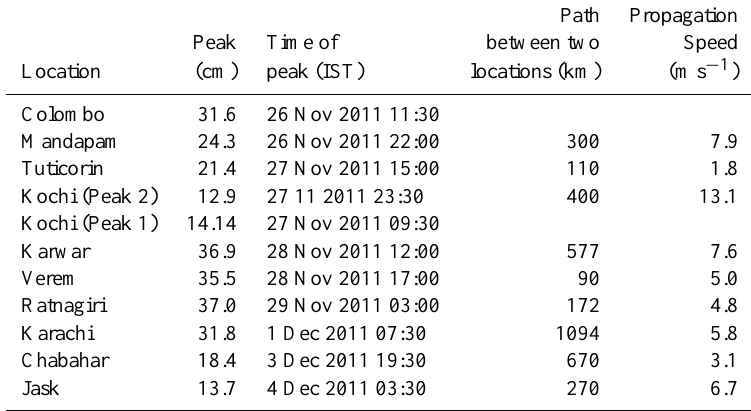
Table 7. Surge propagation parameters during E1 along the west coast of Indian continent. Path Propagation Peak Time of between two Speed Location (cm) peak (IST) locations (km) (ms − 1 ) Colombo 31.6 26 Nov 2011 11:30 Mandapam 24.3